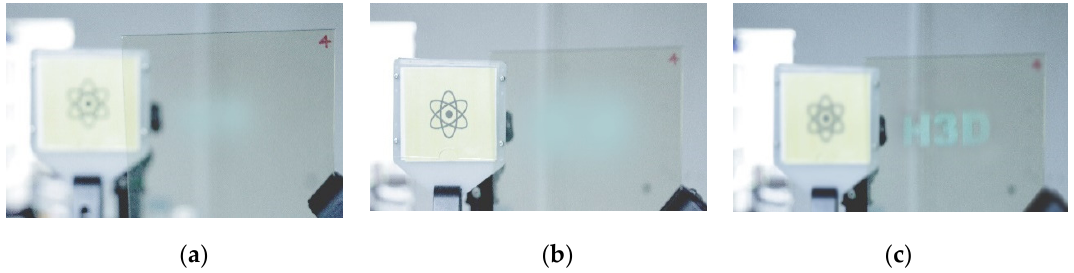
Figure 9. Focal plane distance measurement: ( a ) HOE plane (500 mm); ( b ) target plane (1000 mm); and ( c ) virtual image plane (1500 mm).